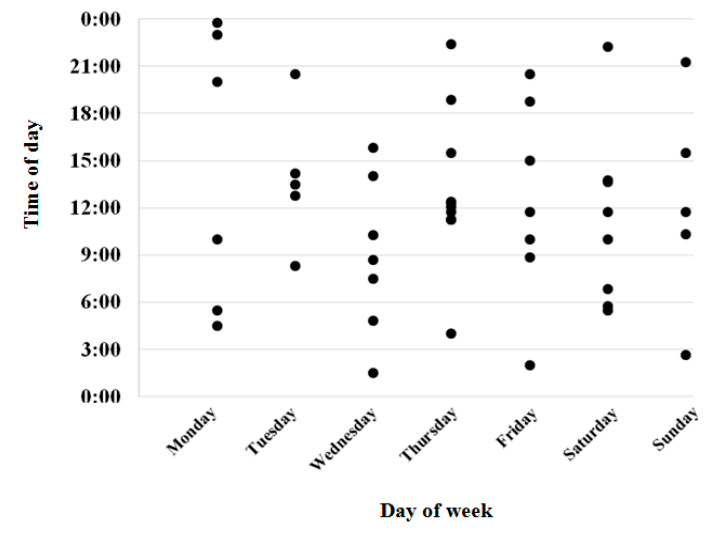
Figure 1. Time and day of hospital transfer among residents hospitalized for infection ( n = 49).